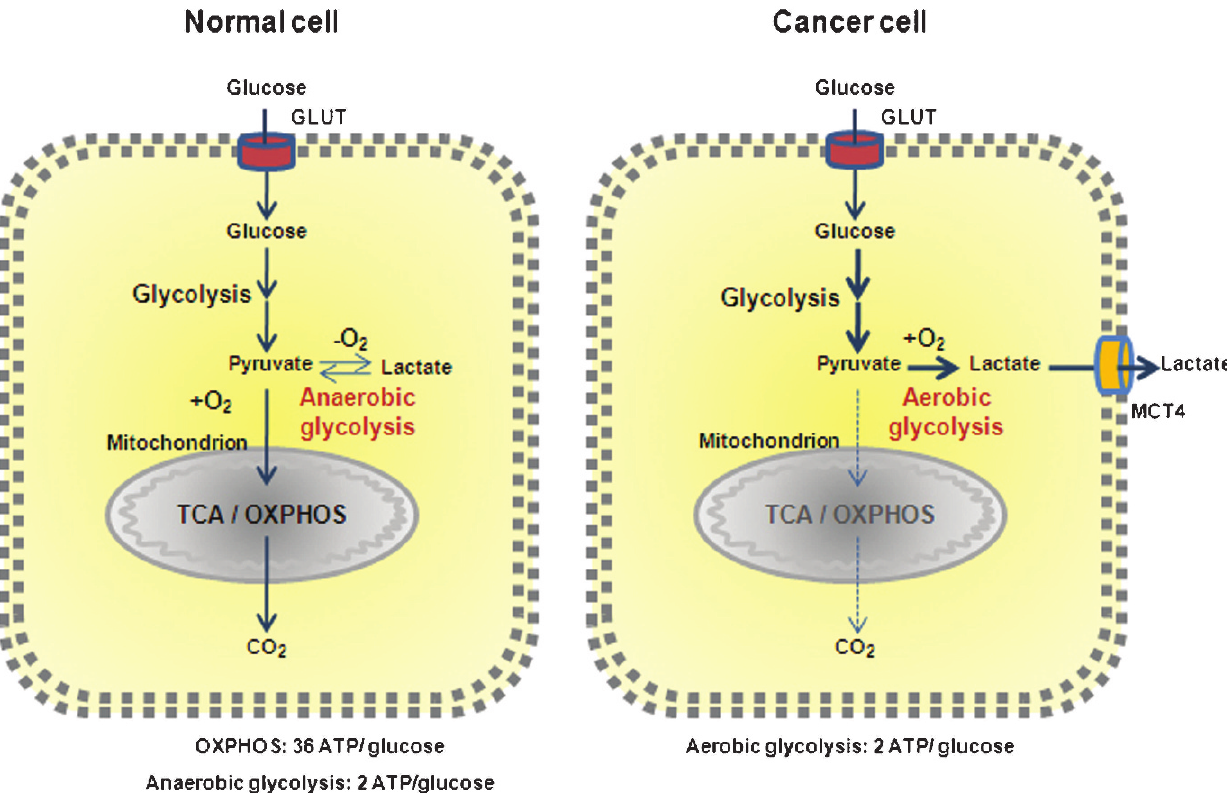
Figure 1 - Metabolic differences between normal and cancer cells. Normal cells primarily metabolize glucose to pyruvate for growth and survival, followed by complete oxidation of pyruvate to CO 2 through the TCA cycle and the OXPHOS process in the mitochondria, generating 36 ATPs per glucose. O 2 is essential once it is required as the final acceptor of electrons. When O 2 is limited, pyruvate is metabolized to lactate. Cancer cells convert most glucose to lactate regardless of the availability of O 2 (the Warburg effect), diverting glucose metabolites from energy production to anabolic process to accelerate cell proliferation, at the expense of generating only two ATPs per